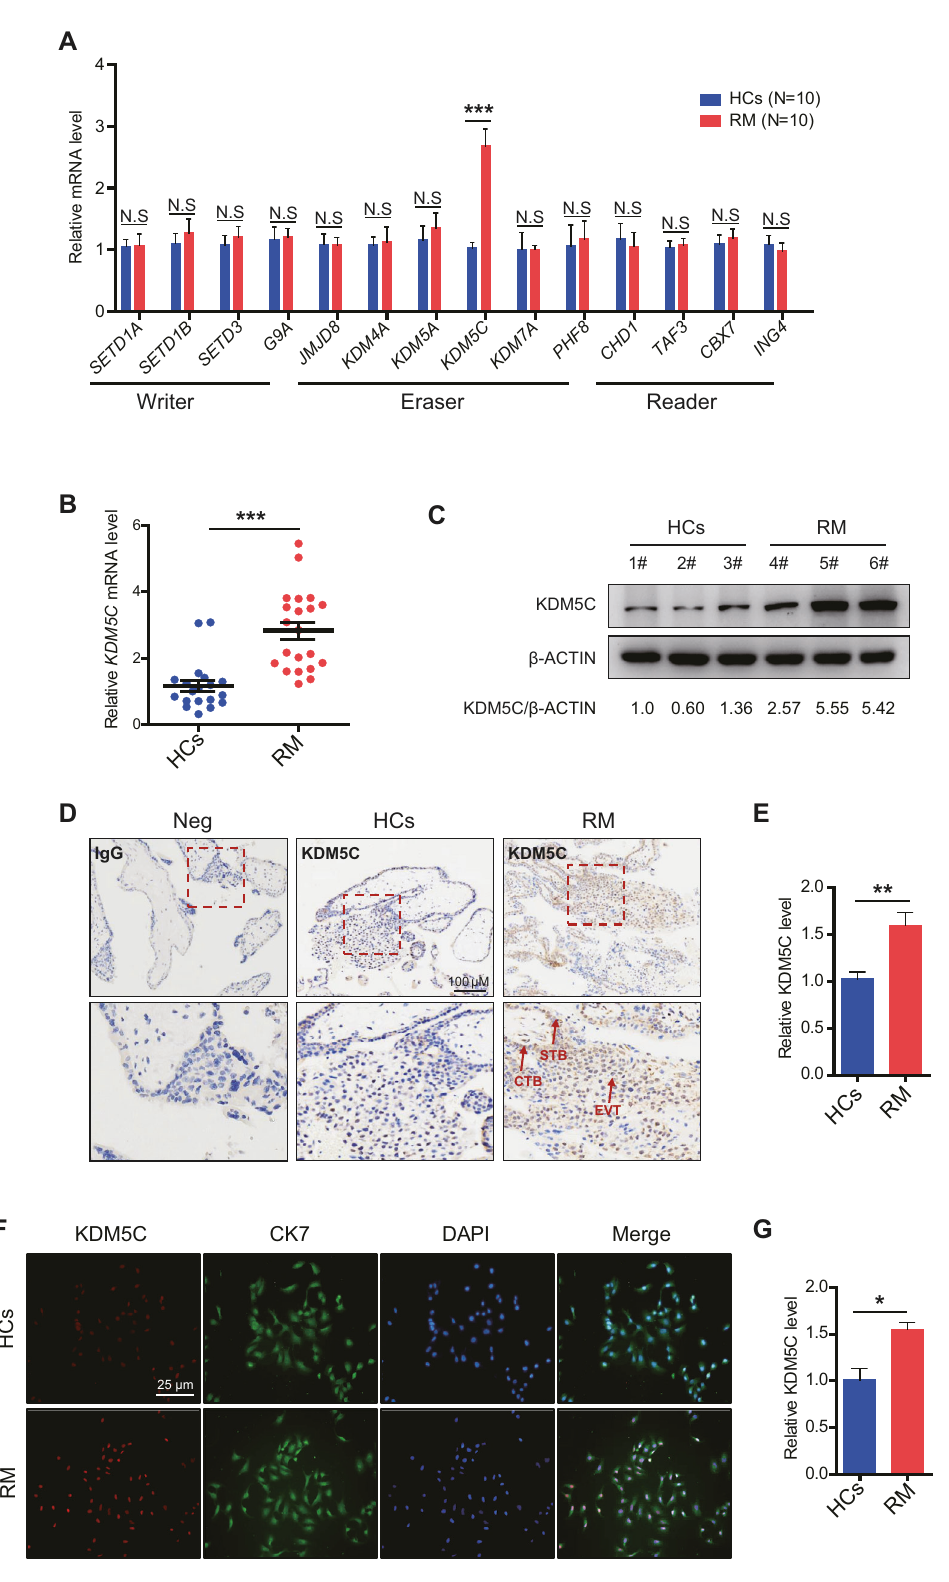
Supplementary Tables 1, 2). Differentially expressed genes were then assessed using gene ontology (GO) based on the Database for Annotation, Visualization, and Integrated Discovery (DAVID) database. Consistent with the functional studies above, GO